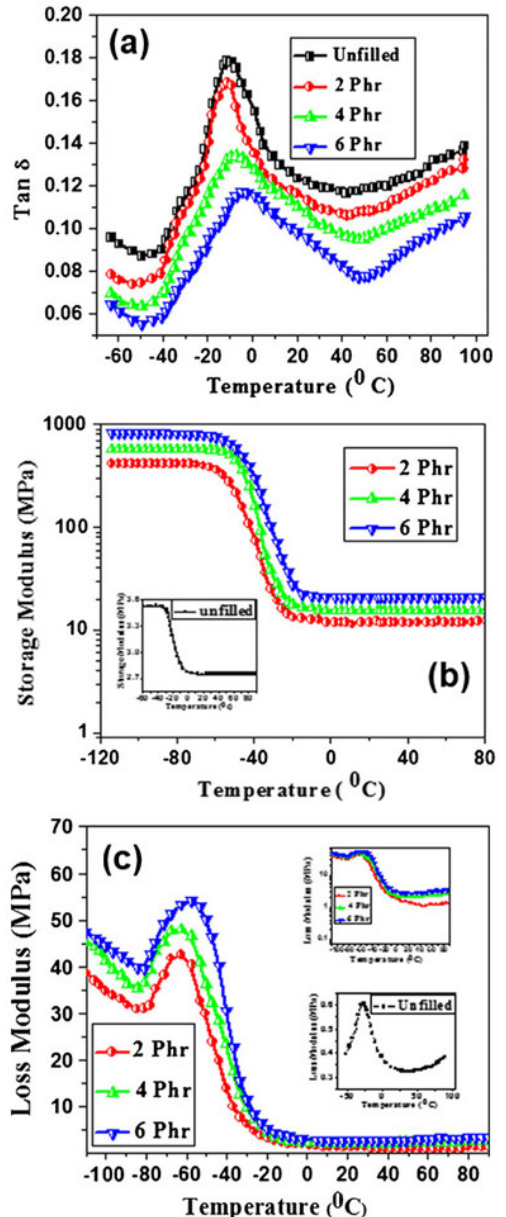
Figure 19. ( a ) Variation of loss tangent (Tan δ) with temperature as a function of MWCNT loading in silicone elastomer nanocomposites; ( b )Variation of storage modulus with temperature as a function of MWCNT loading in silicone elastomer nanocomposites; ( c ) Variation of loss modulus with temperature as a function of MWCNT loading in silicone elastomer nanocomposites. Reproduced with permission from [129], Copyright Springer, 2014.